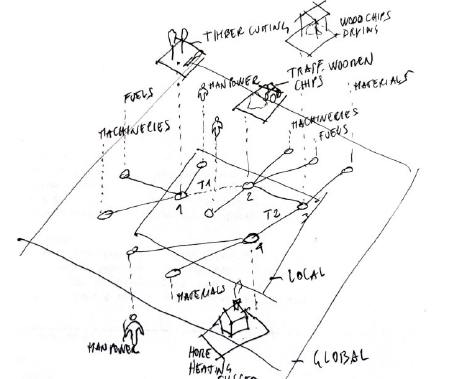
Figure 5. S upply chain simplified Impact Geography of local wooden biomass for winter